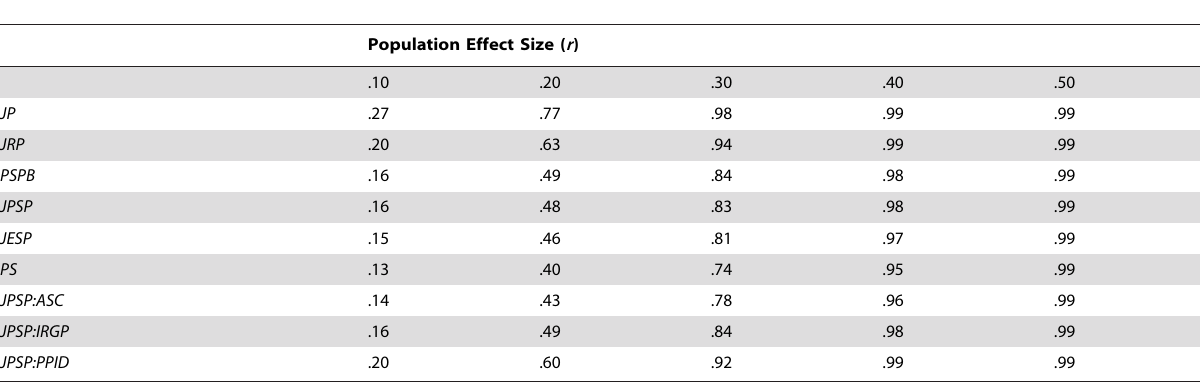
Table 4. Statistical Power to Detect Various Population Effect Sizes across Journals.